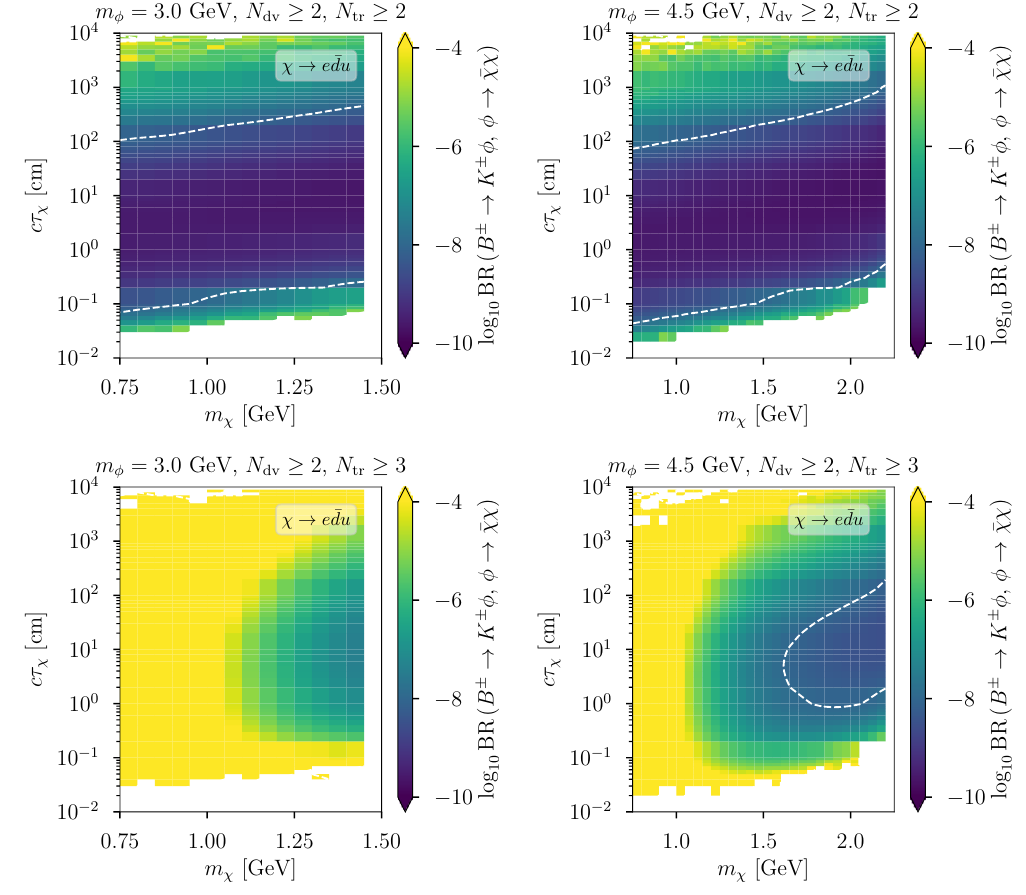
Figure 12 . B meson branching fraction sensitivity of Belle II based on 10 signal events in a 50 ab − 1 dataset for LLPs χ decaying to e + hadrons and the B decay production mode (summed over available kaon final states). The upper (lower) row shows the result of demanding at least 2 (3) charged tracks from two displaced vertices. The left (right) column fixes m = 3 ( 4 . 5 ) GeV. φ The white dashed contours correspond to a production cross section of 10 − 2 fb , which is roughly equivalent to dark Higgs mixing θ ∼ 10 − 4 for m 4 . 5 GeV φ ≤